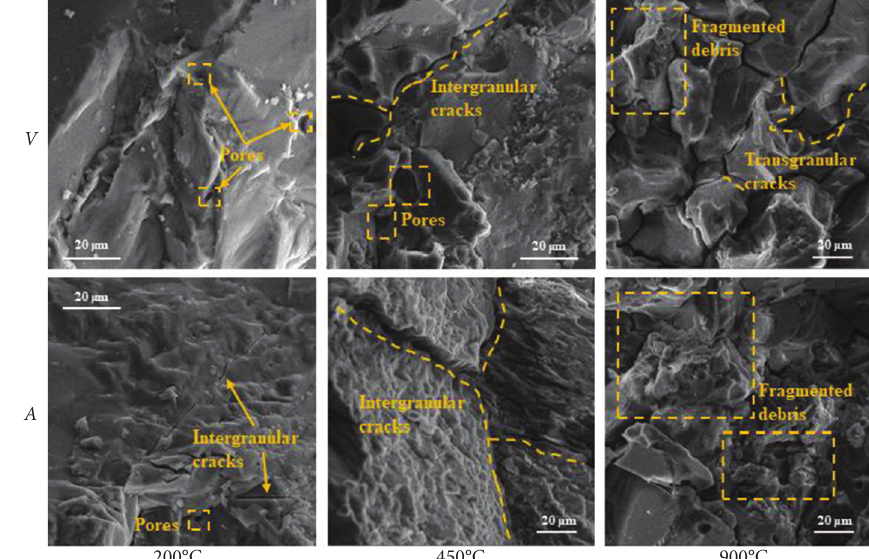
Figure 14: SEM images of thermally treated limestone specimens with different temperature and heating